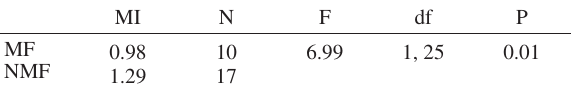
Table 4. – Factorial analysis of variance to evaluate differences in reproductive output between young of the year and older females. Differences between years and age-years interaction were also evaluated. SS, sum of squares; df, degrees of freedom; MS mean